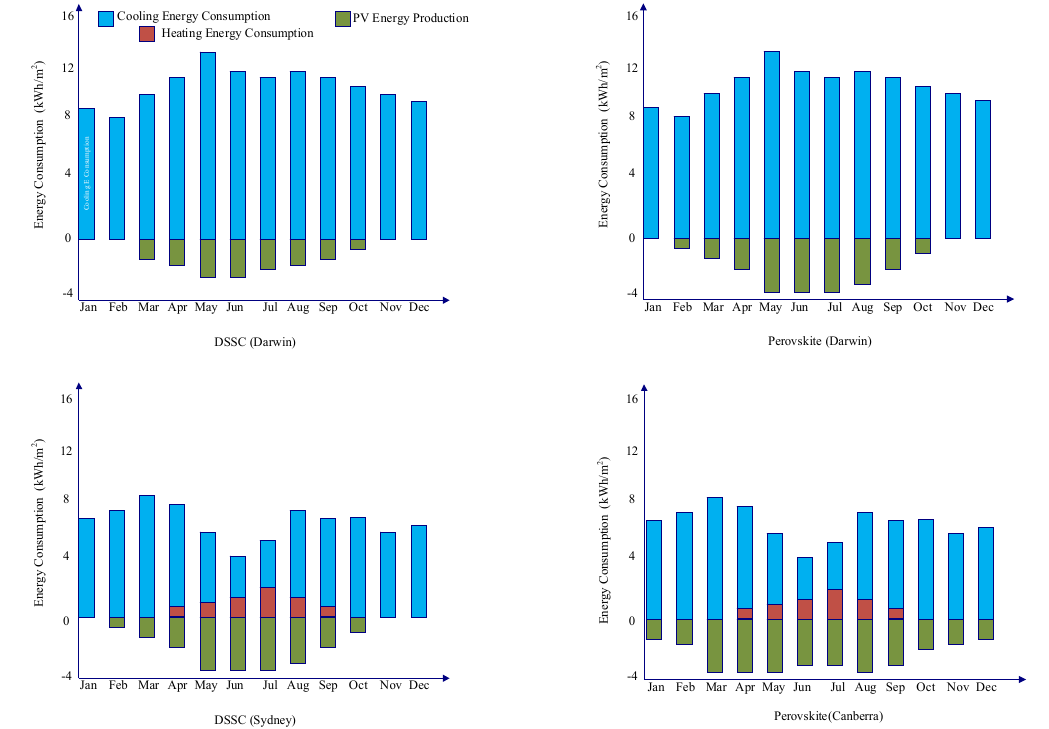
Figure 15. DSSC and Perovskite solar cell for Darwin (hot, humid climate), Australia [47]. Each set of bars represents the monthly value of heating (orange) and cooling (blue) energy consumption and PV production (green) for the four